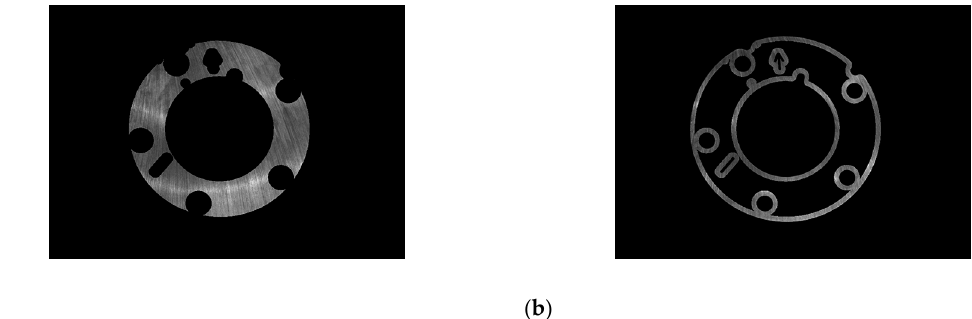
Figure 6. Division of parts: ( a ) the central panel region; ( b ) the central panel region.